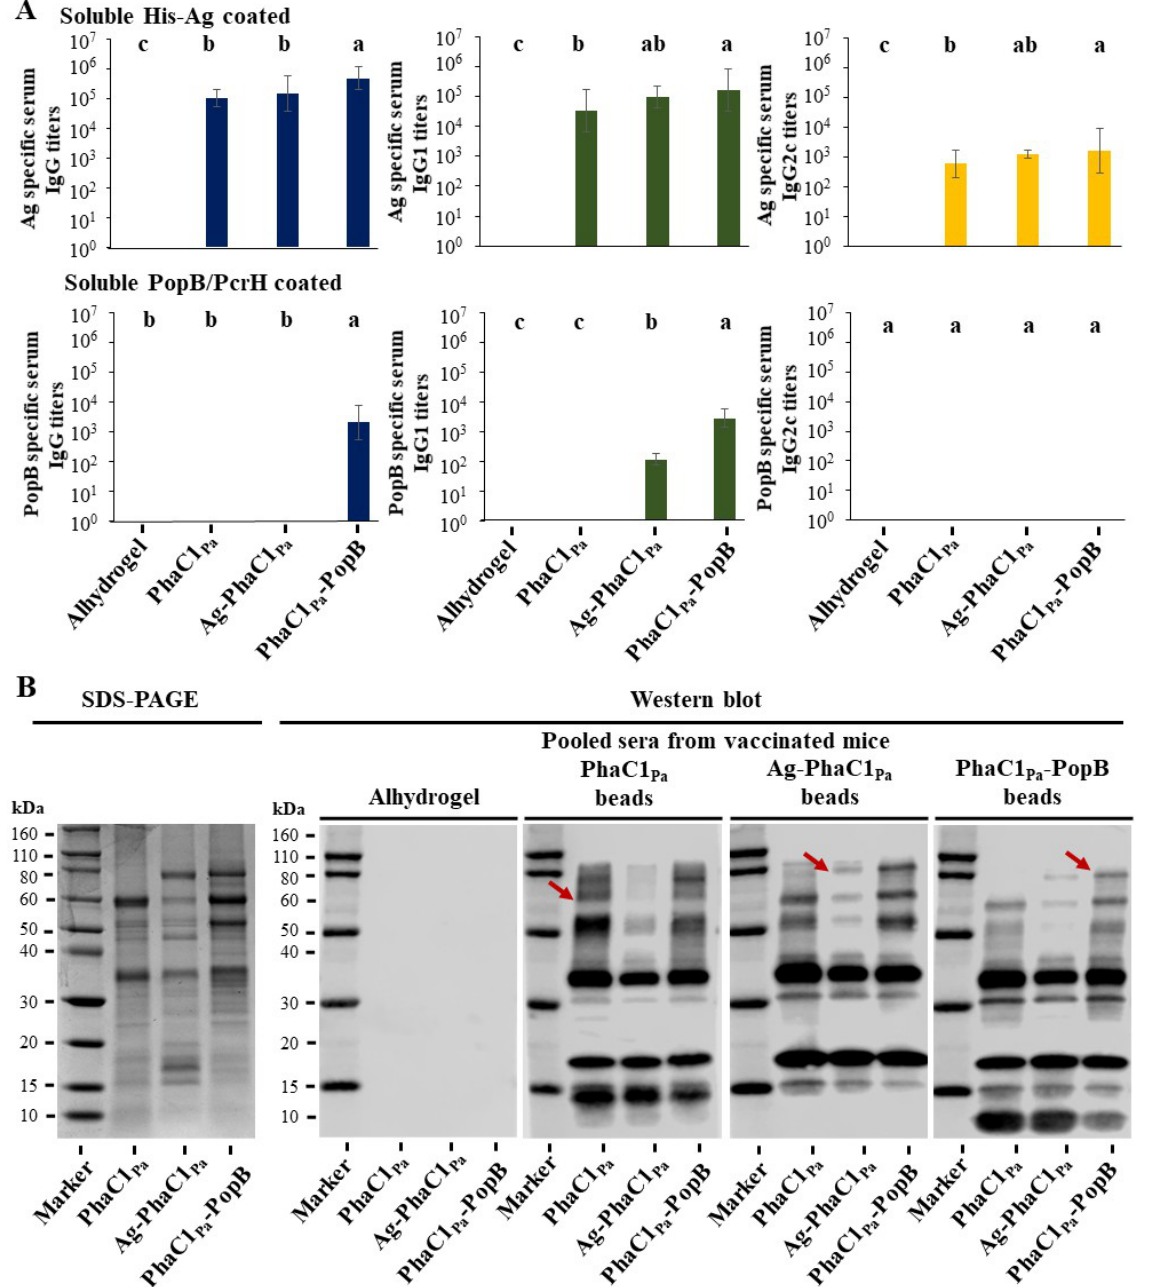
Figure 4. Antigen-specific antibody responses in mice vaccinated with different PHA beads. ( A ) Antigen-specific total IgG, IgG1 or IgG2c antibody responses measured by ELISA. Each data point represents results from 12 mice ± SEM. Statistical analysis was done by one-way ANOVA with statistical significance ( p < 0.05) indicated by letter-based representation of pairwise comparisons between groups using Tukey’s post hoc test (i.e., data with different letters are statistically significant). ( B ) Specific antigen recognition by immunoblot using pooled antisera from PHA bead-vaccinated mice (n = 12 per group). PhaC1, Ag-PhaC1 and PhaC1-PopB are in red